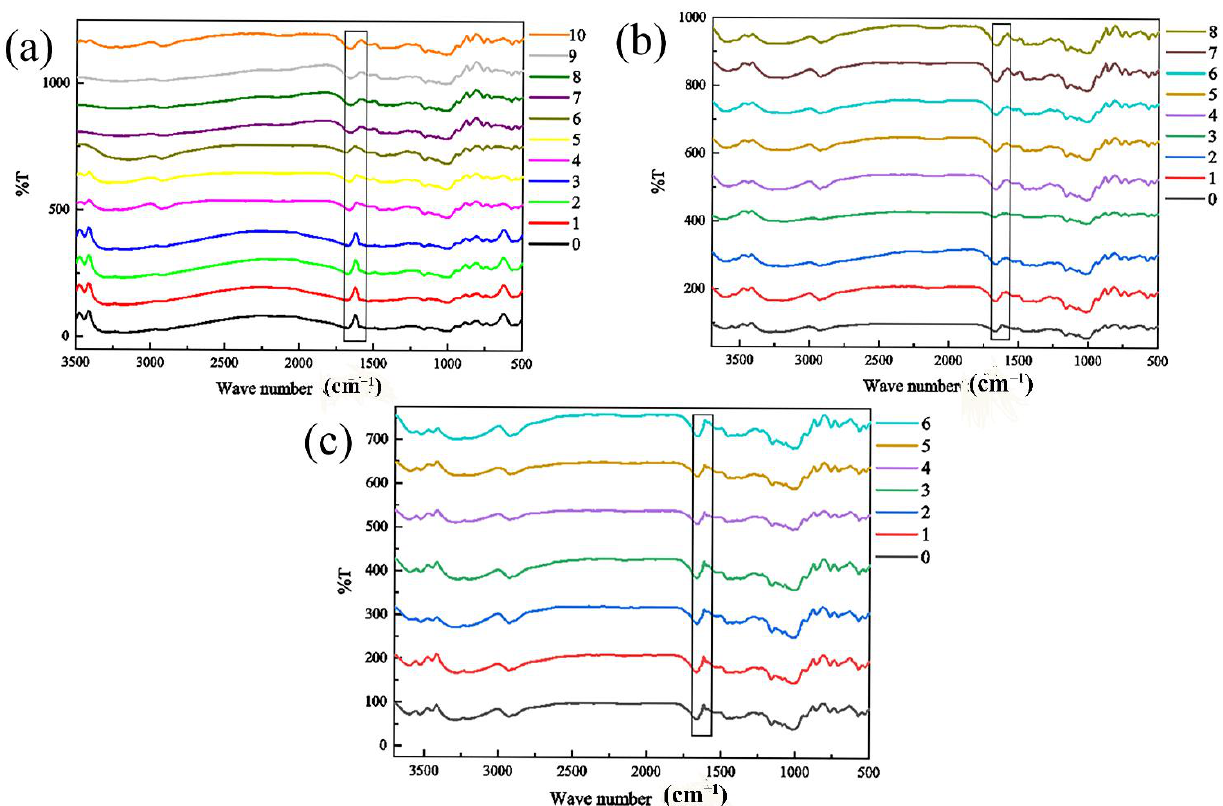
Figure 7. The change in the infrared spectrum of rice under ambient humidity of 80% different stor- age temperatures ( a ) 20 °C, ( b ) 30 °C, and ( c ) 35 °C.